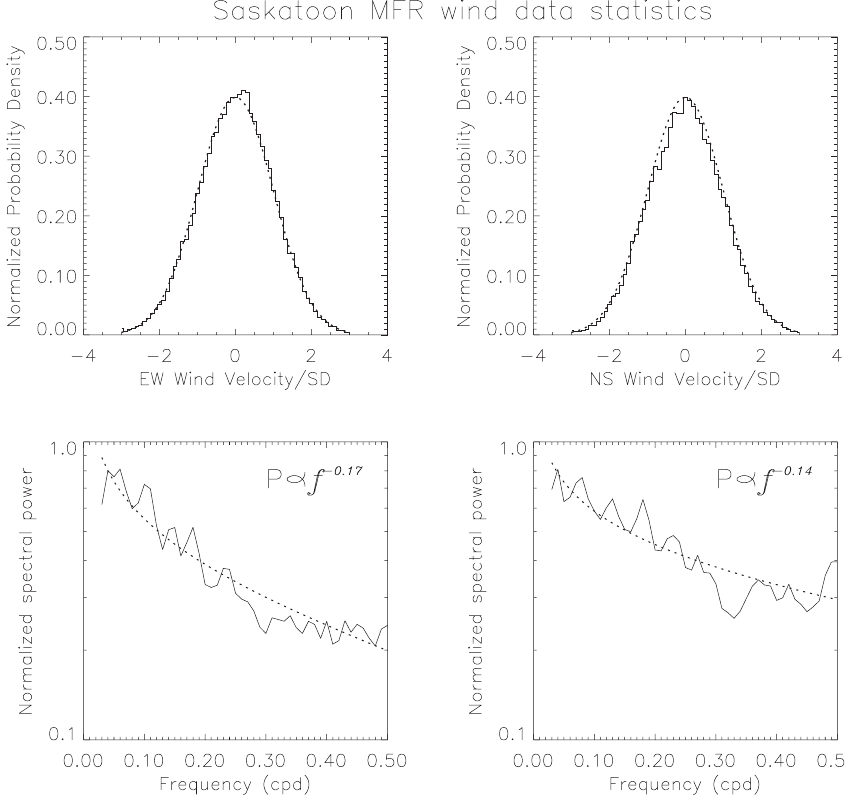
Fig. 2. Upper diagrams: The normalized (by standard deviation) distributions for the zonal (EW) and meridional (NS) winds at Saskatoon in 1994 (histograms), and the Gaussian (standard) distributions (dotted curves). Bottom diagrams: The averaged Fourier spectra for the above two components of wind; the dotted curves are their least-square fittings by an exponential function of frequency ( f ) whose parameters are shown on the upper-right